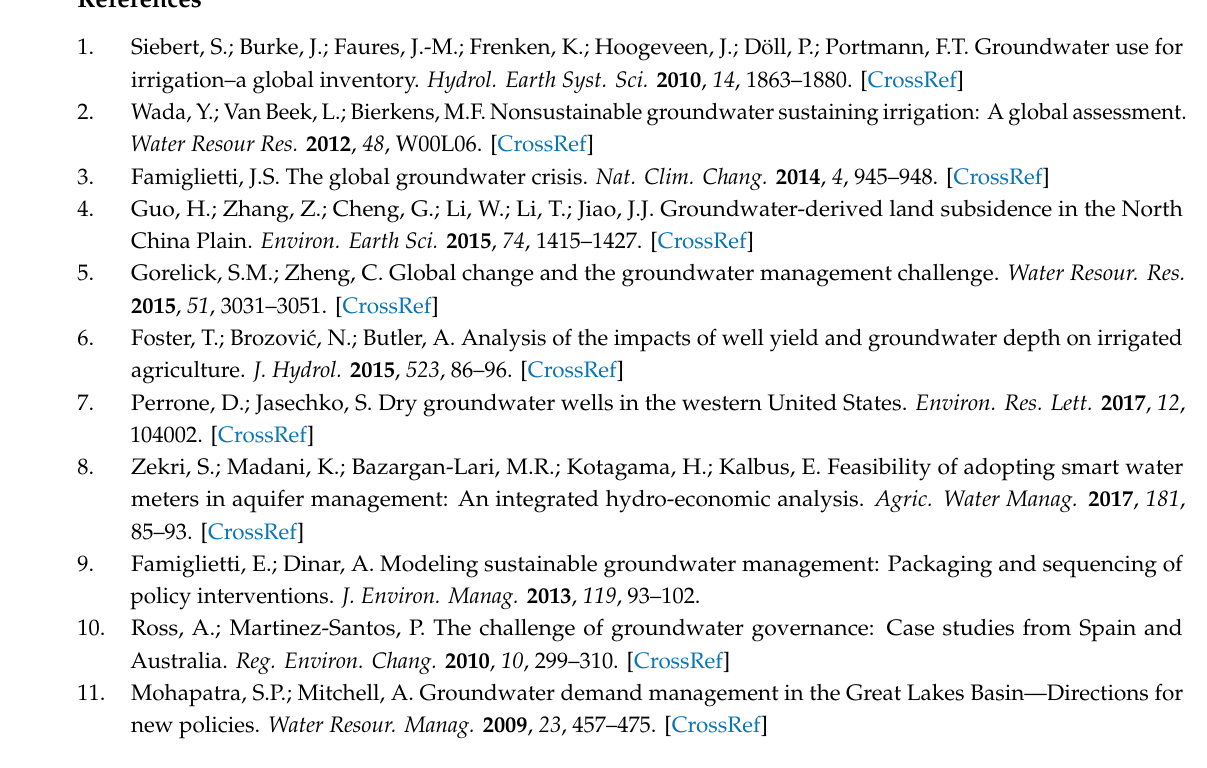
Figure S1: Time series of conversion factors at Well 5 (a) and Well 6 (b) with the means of grouped measurements and the range of ± 20% of the